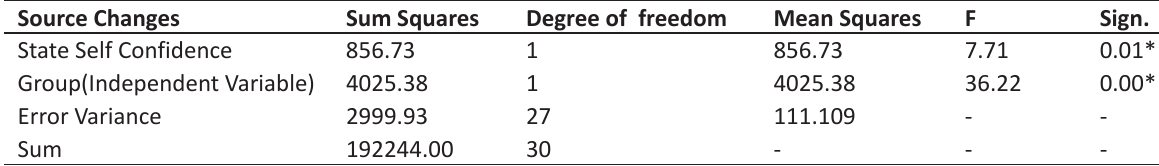
Table 5. Adjusted Mean after Eliminating the Effect of Pretest Mean